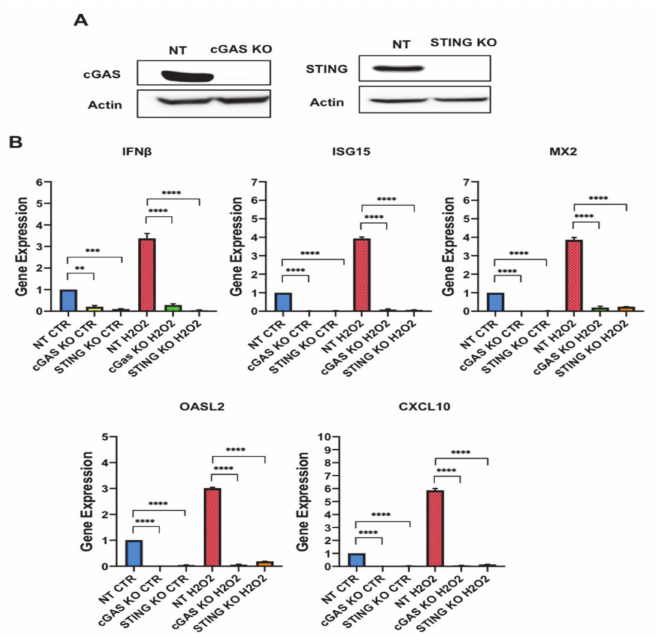
Figure 6. GMP-AMP synthase (cGAS) and stimulator of interferon genes (STING) regulate the gene expression of interferon signalling-related genes in preadipocytes. ( A ) Western blot assessing the protein levels of cGAS and STING in control Non Targeting (NT), cGAS Knockout (KO), STING KO cells. Actin was used as loading control. ( B ) Gene expression analysis for interferon signalling- related genes (interferon β (IFN β ), interferon-stimulated gene 15 (ISG15), MX dynamin-like GTPase 2 (MX2), oligoadenylate synthetase-like 2 (OASL2) and C-X-C motif chemokine ligand 10 (CXCL10)) in untreated NT, cGAS KO, and STING KO preadipocytes vs. H 2 O 2 treated counterparts as indicated. Results (Relative expression) are presented as means ± SEM from three independent